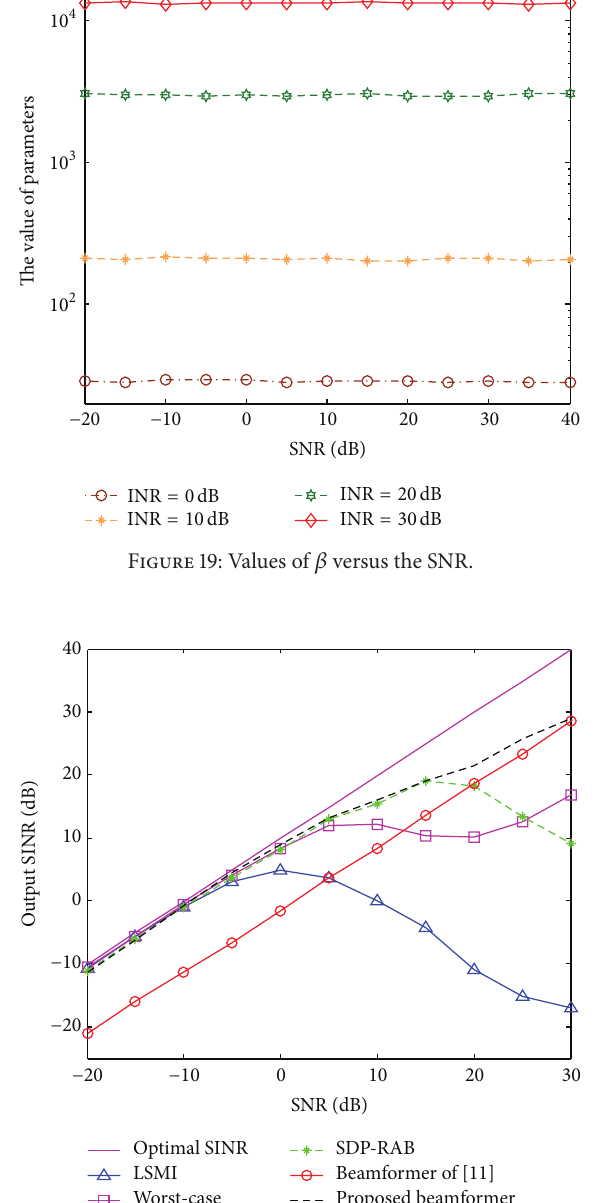
Figure 20: Output SINR versus the input SNR (INR = 30 dB).